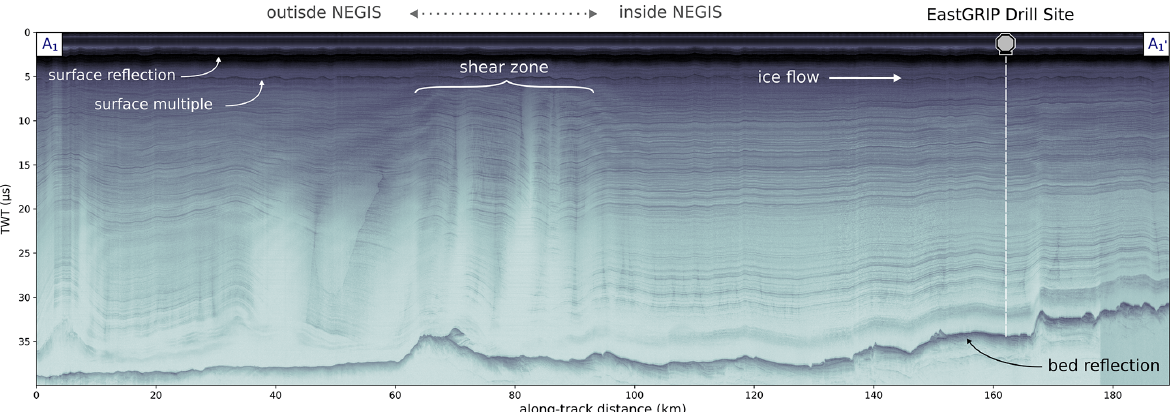
Figure 2. Flow-parallel radar profile A composed of four frames: 20180512_01_001–004. The location is indicated in Fig. 1a and covers the area outside of the ice stream, the shear zone, and the ice stream’s trunk. The position of the EastGRIP drill site is labeled and indicated with a vertical dashed white